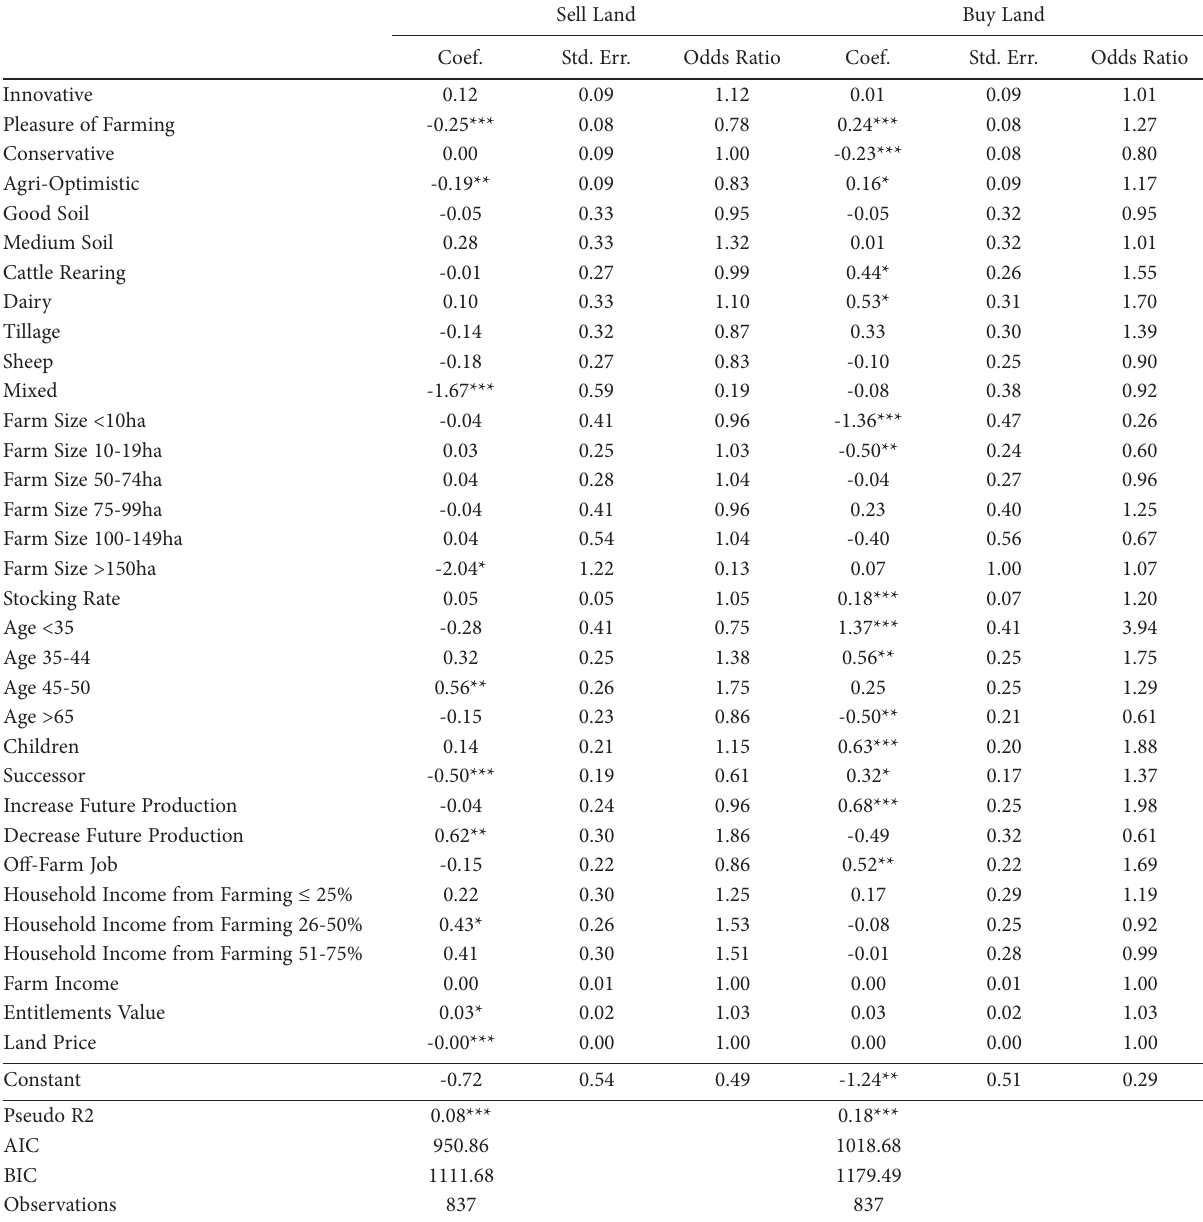
Table 6. Factors related to the probability farmers are open to selling/buying land. Sell Land Buy Land Coef. Std. Err.